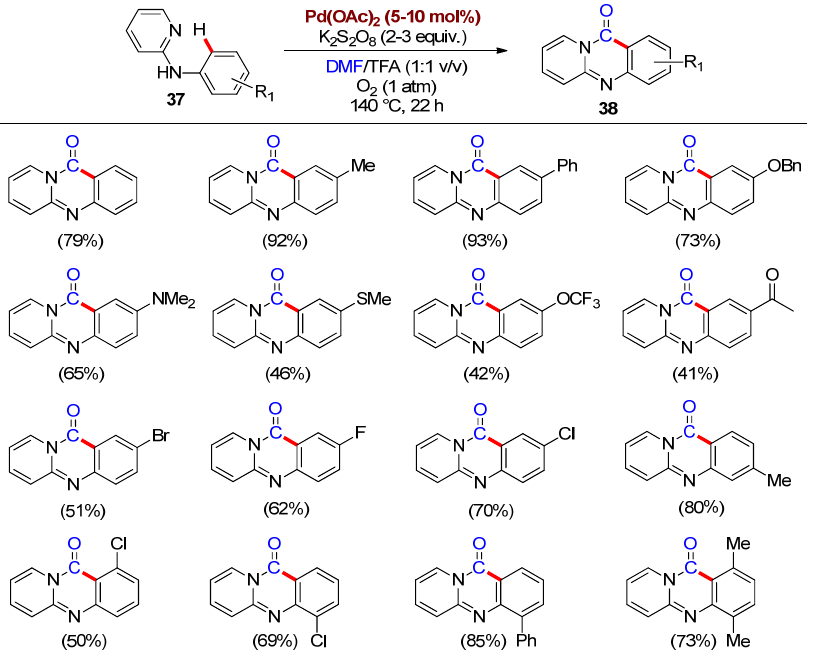
Scheme 14. Pd-catalyzed carbonylative cyclization of N -arylpyridin-2-amines 37 using DMF as